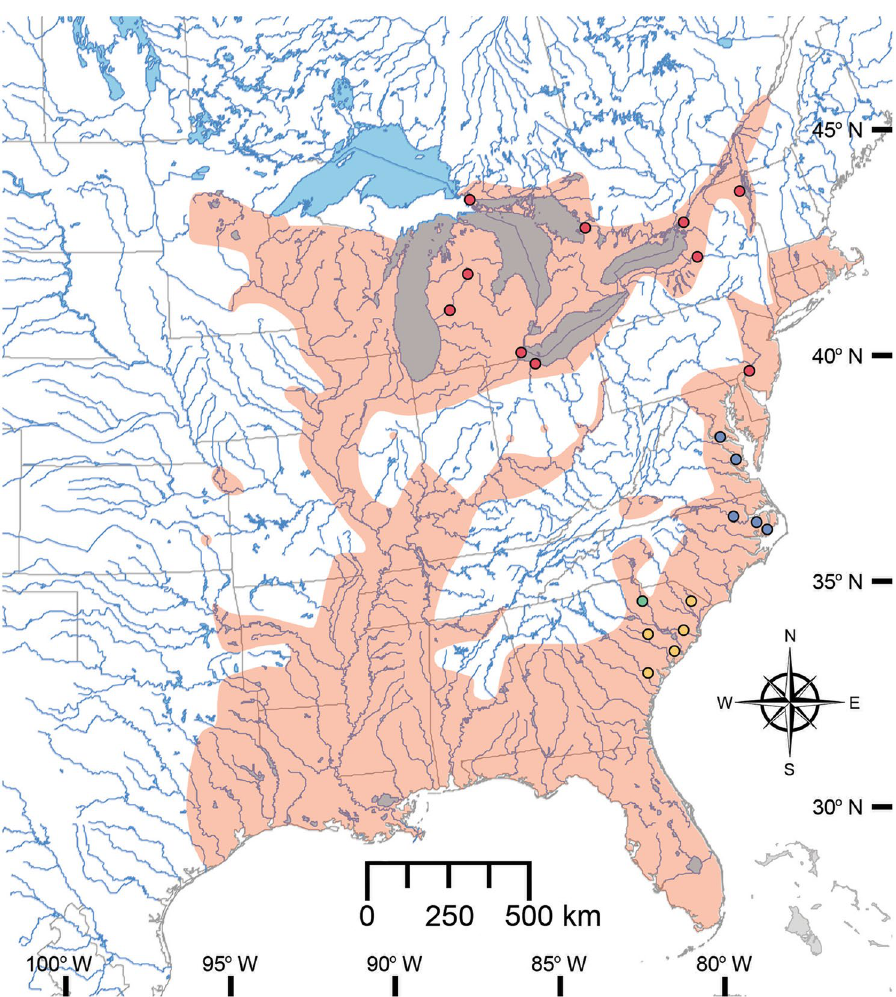
Figure 1. Currently recognized distribution of Amia calva (red shading). Dots represent sampling locations, with colors corresponding to population clusters shown in Fig. 2a. Range is redrawn from Page and Burr 17 , using a modified version of a map of North American lakes and rivers provided by the Commission for Environmental Cooperation (http:// www. cec. org/ north- ameri can- envir onmen tal- atlas/ lakes- and- rivers-